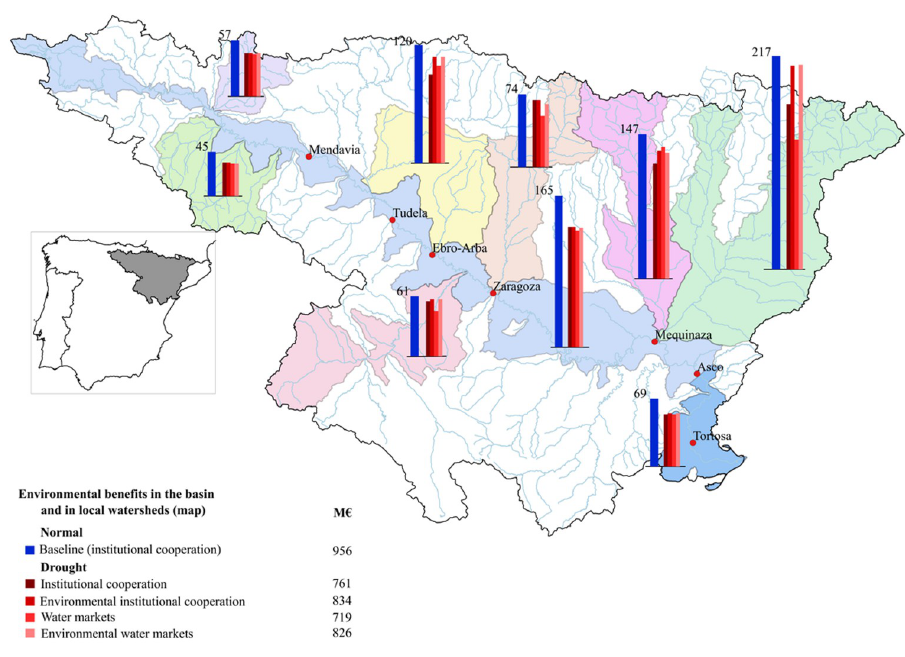
Fig 3. Environmental benefits of policies under normal and drought conditions. Reprinted from Confederacio´n Hidrogra´fica del Ebro under a CC BY license, with permission from Confederacio´n Hidrogra´fica del Ebro.